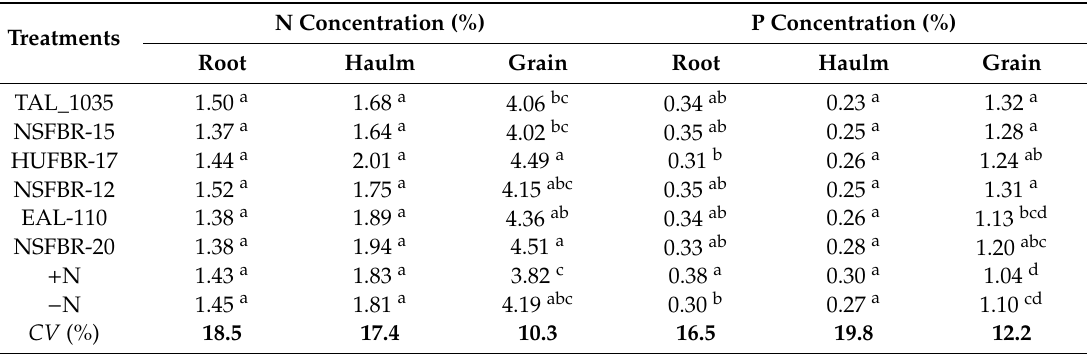
Table 4. Root, haulm and grain nitrogen and phosphorus concentrations in faba bean inoculated with di ff erent rhizobium